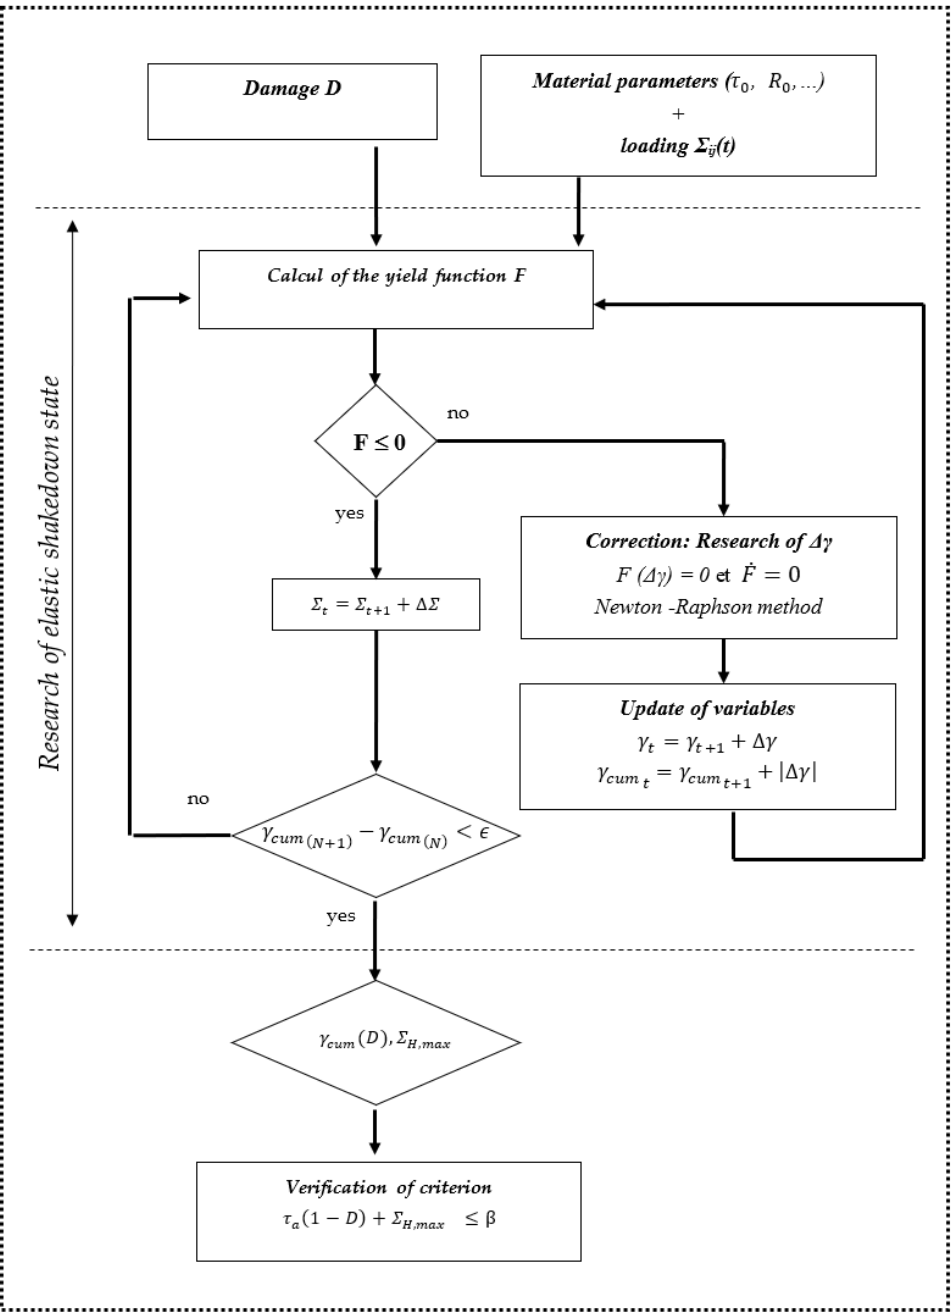
Figure 3. Algorithm of elastic shakedown.